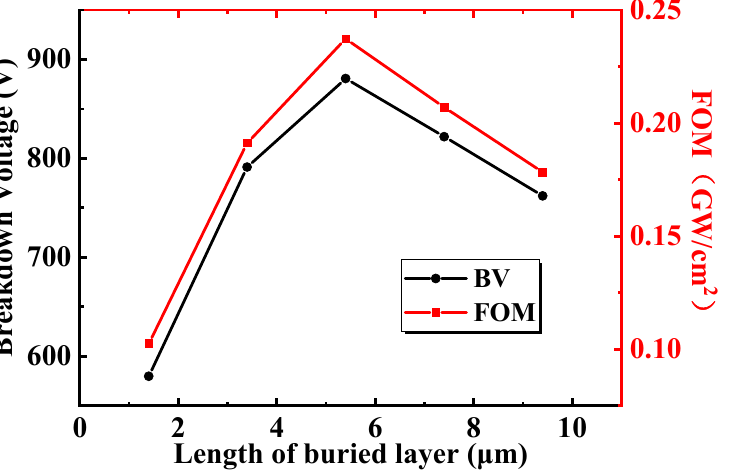
Figure 6. The influence of the length of the buried layer on the breakdown voltage and the FOM of the proposed BP HEMT.